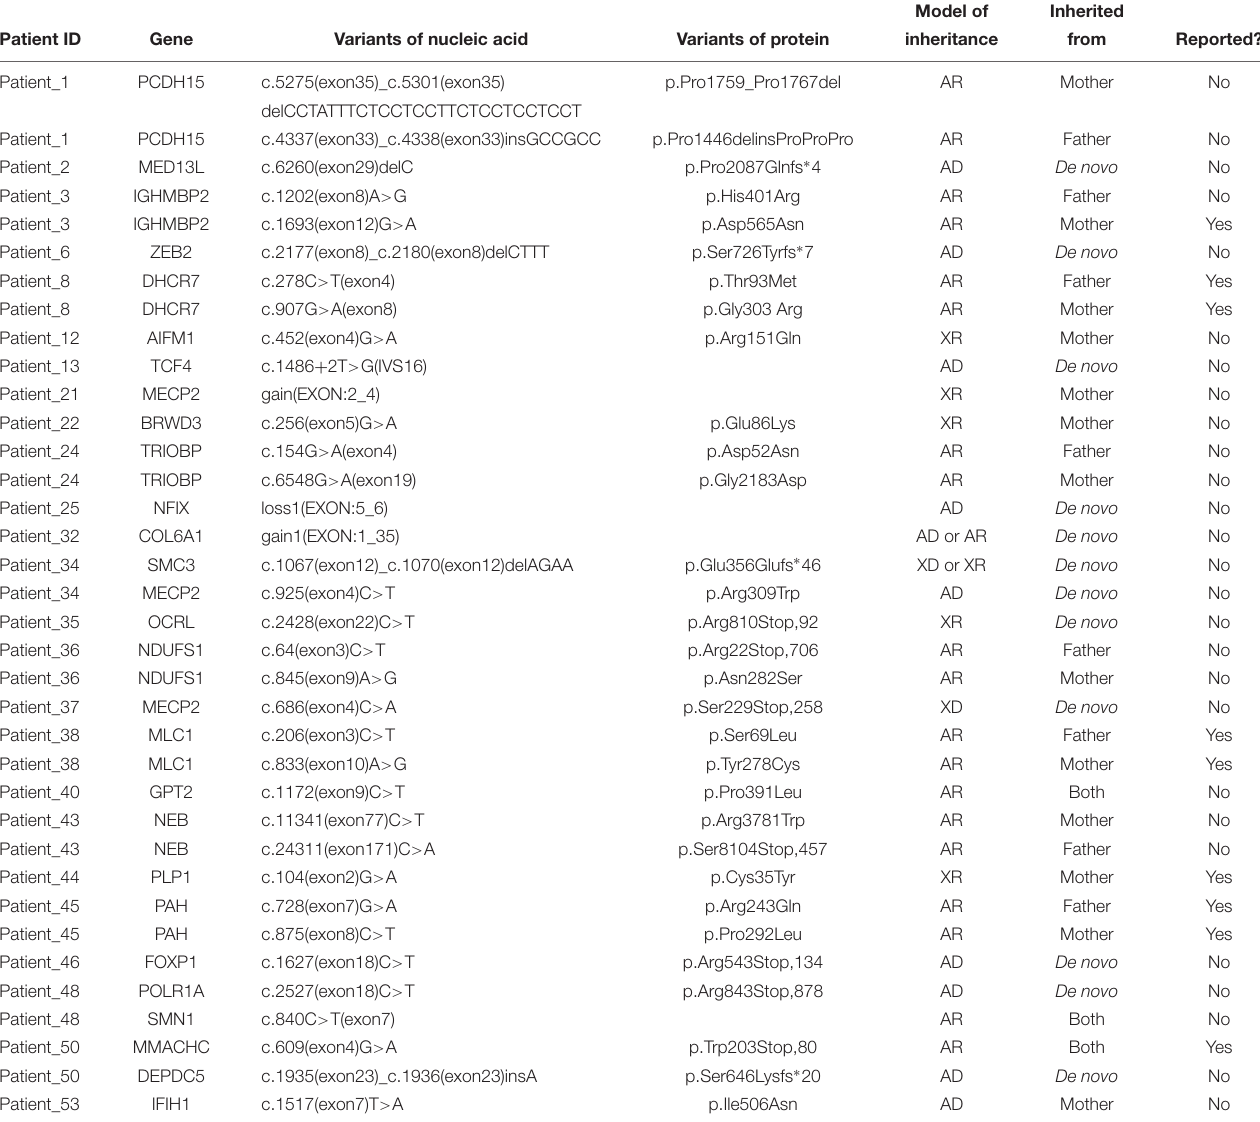
TABLE 1 | WES diagnostic testing characteristics of families with children with developmental